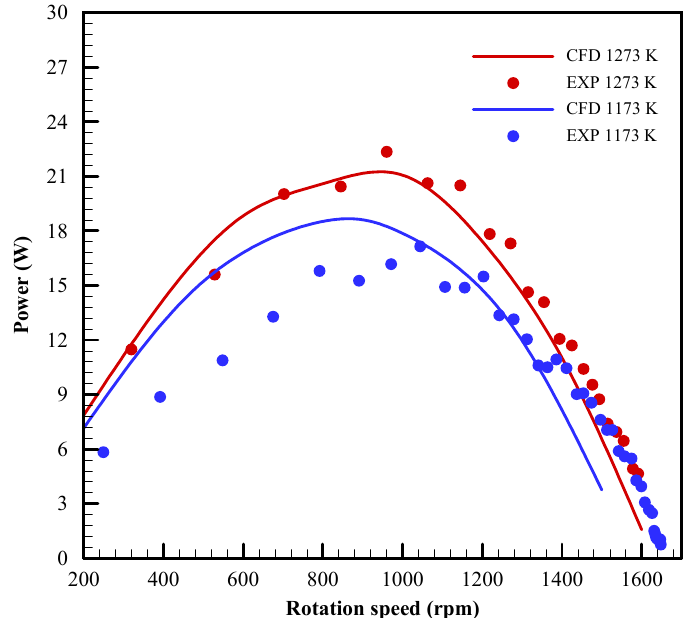
Figure 5. Comparison between present CFD predictions and experimental data [24].